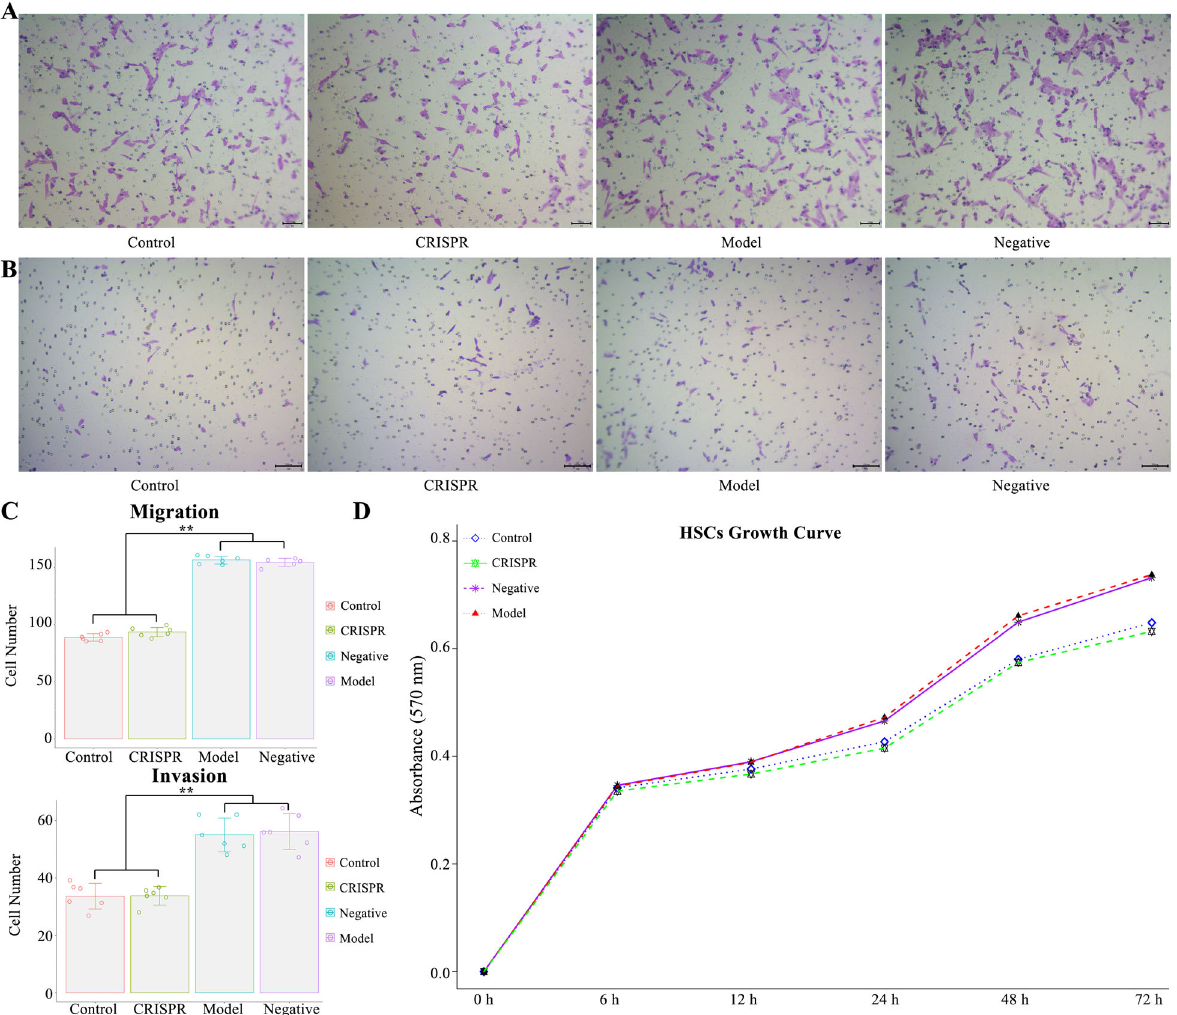
Fig. 3 RSPO4-CRISPR represses HSC ’ s ability of migration, invasion, and growth. A Transwell assay showed RSPO4-CRISPR decrease HSCs ’ ability of migration (bar 100 μ m, magni fi cation ×100). B Transwell assay showed RSPO4-CRISPR reduce HSCs ’ ability of invasion (bar 100 μ m, magni fi cation ×100). C Cell number of both migration and invasion decreased signi fi cantly in the CRISPR group compared with the model group. D MTT assay showed RSPO4- CRISPR downregulated HSCs proliferation. HSCs isolated from the CCl 4 -induced fi brotic-liver rats were noted as the model group, cells transfected with RSPO4-CRISPR was noted as the CRISRP group and HSC isolated from normal rats served as the control. Data represent the mean of three independent experiments, and error bars are the standard deviation of means. * p < 0.05 compared with the control, ** p < 0.01 compared with the